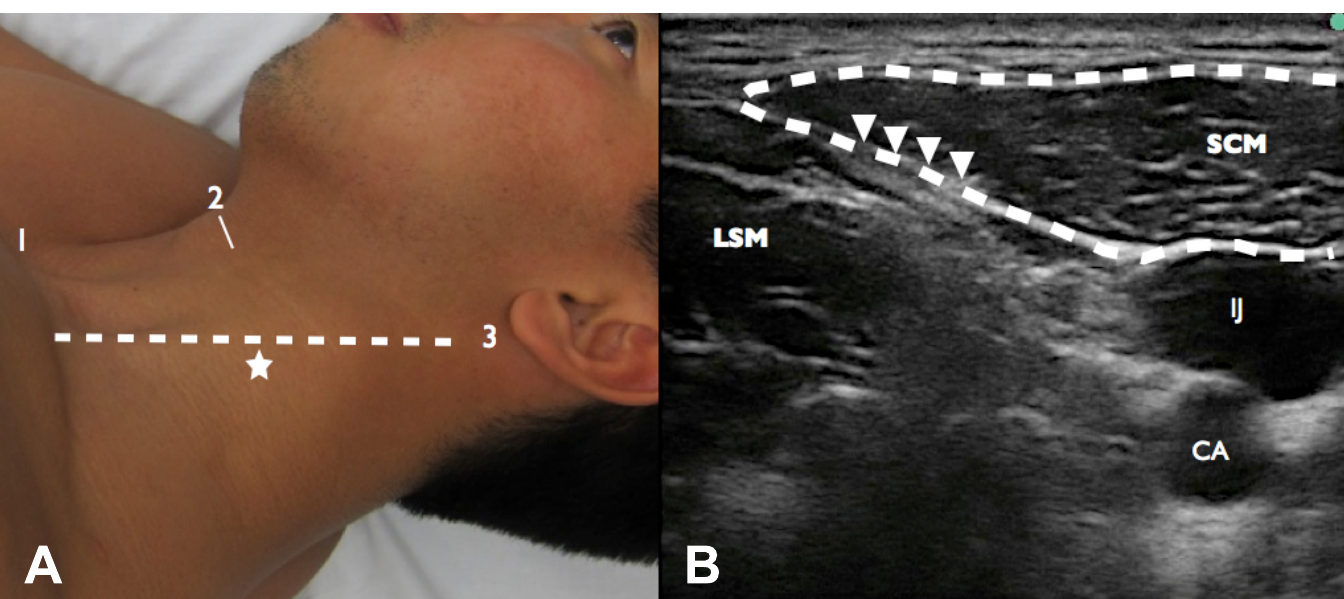
Figure 1. A , Key surface landmarks include the (1) sternal notch, (2) superior pole of the thyroid cartilage, (3) the mastoid process, and (dashed line) the posterolateral border of the sternocleidomastoid muscle (SCM). The injection site is marked (star). B , Survey ultrasound scan showing the tapering posterolateral border of the sternocleidomastoid (SCM) outlined in red, the internal jugular vein (IJ), the carotid artery (CA), and the levator scapulae muscle (LSM). The superficial cervical plexus just deep to the muscle is marked (arrow heads).